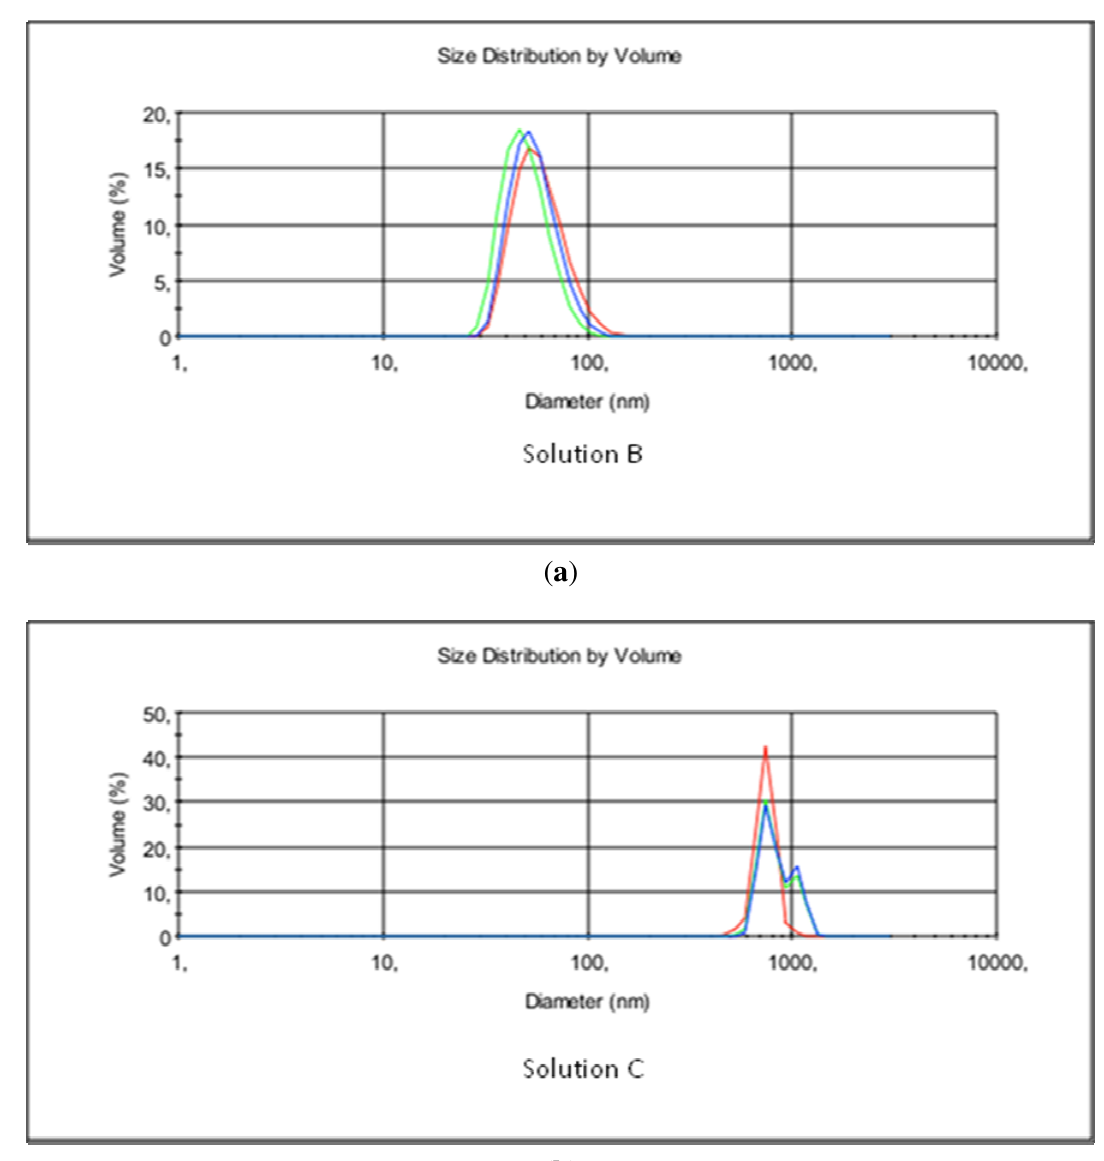
Figure 1. ( a ) Particle size distribution of β -TCP in chitosan solution in hydrochloric acid (solution B); ( b ) HAp particles in chitosan acetate solution (solution C); ( c ) The HAp/ β -TCP blend in chitosan (solution